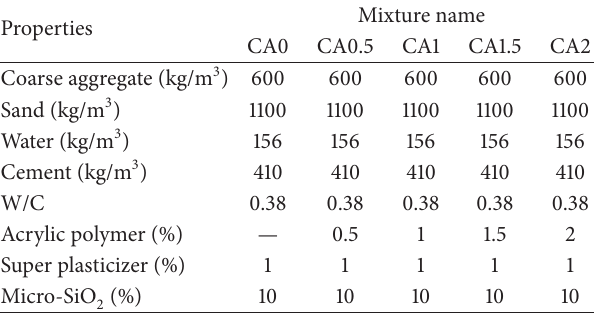
Table 3: SCC mixture